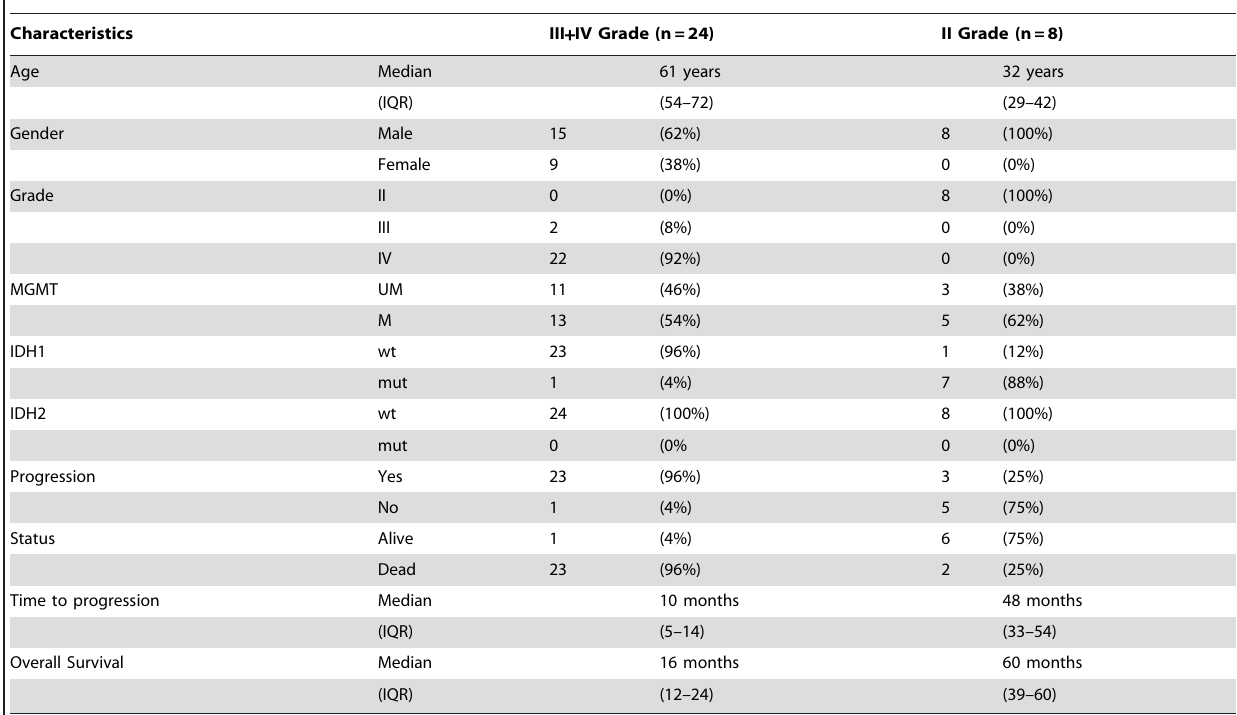
Table 1. Clinico-pathological characteristics of patients cohort.